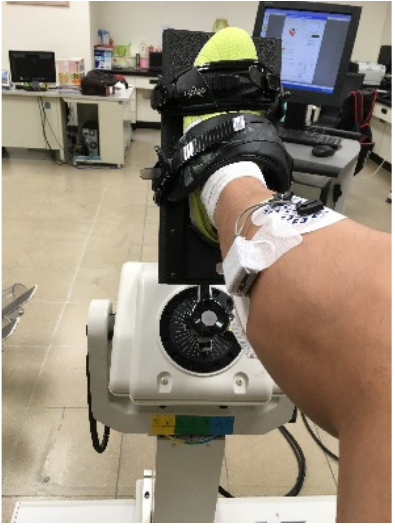
Figure 1. Biodex isokinetic dynamometer.